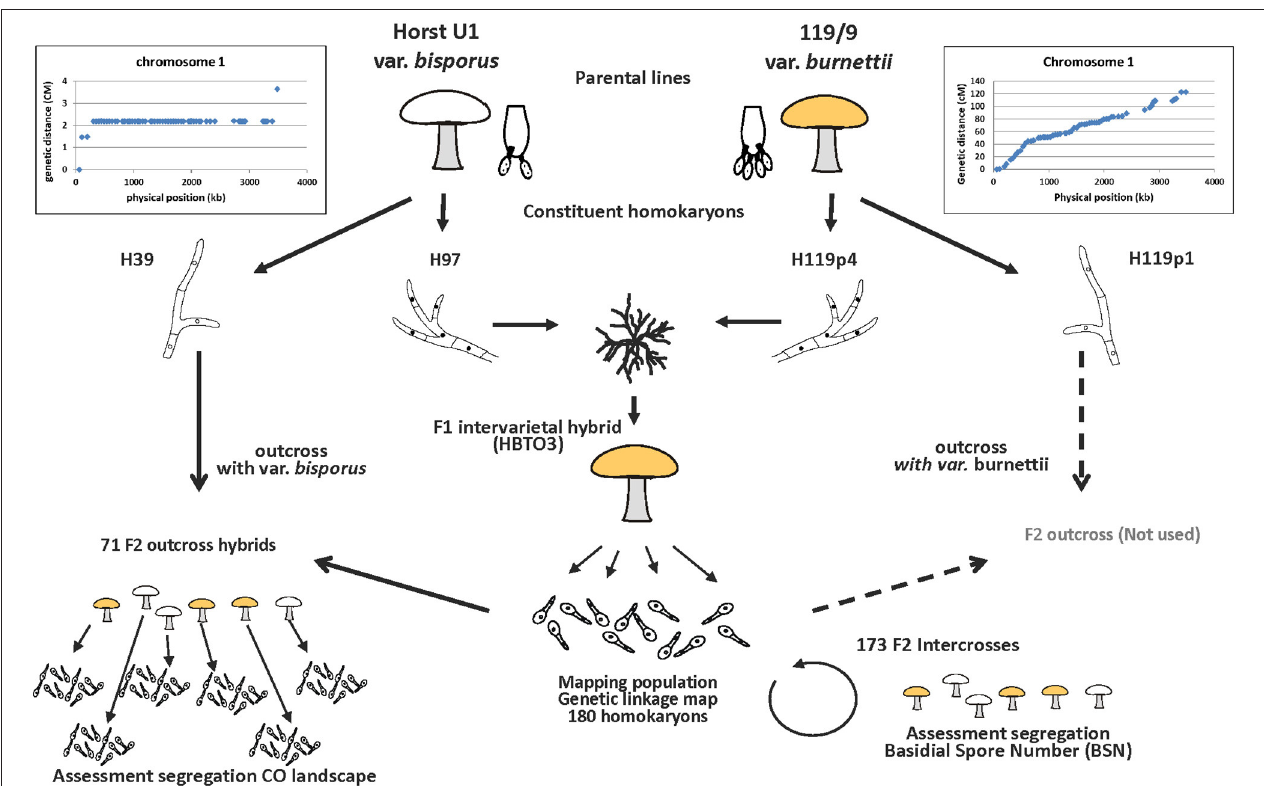
FIGURE 1 | Experimental setup for mapping the basidial spore number and crossover (CO) landscape. The donors of the parental homokaryons are var. bisporus (predominantly 2-spored basidia and CO at chromosome ends) and var. burnettii (predominantly 4-spored basidia and CO evenly distributed over chromosomes). A constituent homokaryon of var. bisporus (derived from the commercial variety Horst U1) and a constituent homokaryon of the var. burnettii 119/9 (wild isolate) were crossed (F 1 intervarietal hybrid HBT03) to generate a mapping population (haploid offspring of HBT03). A selection of this mapping population was subsequently intercrossed to map the basidial spore number (BSN) and outcrossed with the var bisporus homokaryon H39 to map the CO